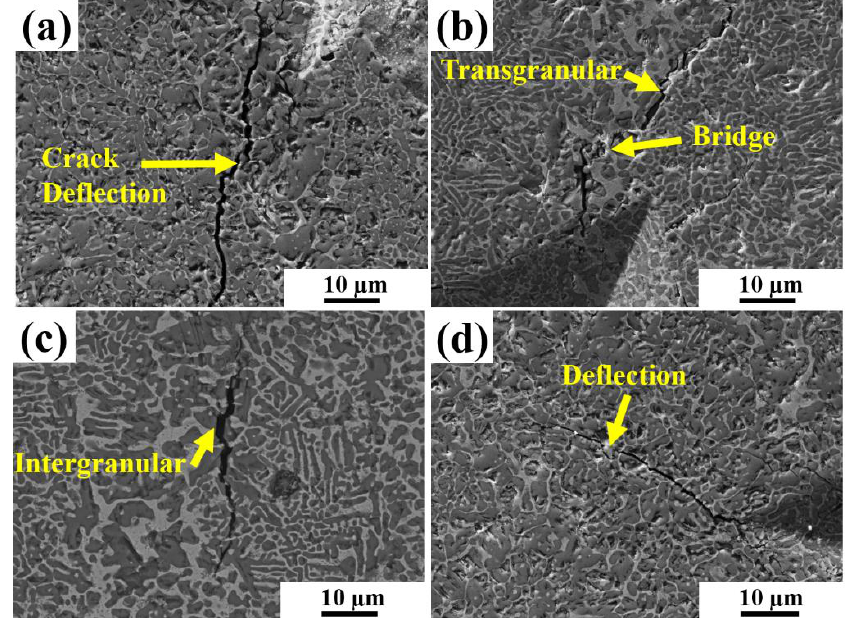
Figure 8. SEM images of the crack propagation path in TiC – Fe cermet with different laser process parameters ( a ) LMP50, ( b ) LMP60, ( c ) LMP70, ( d )